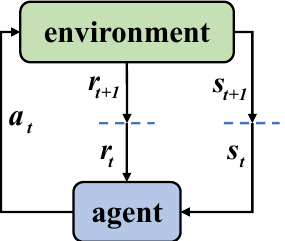
Figure 2. Markov decision